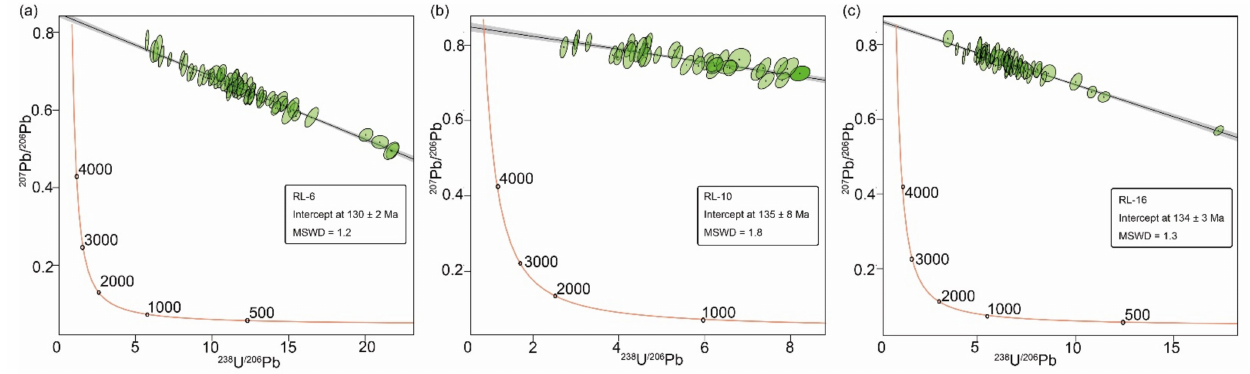
Figure 9. Apatite U-Pb lower intercept ages of the ( a ) RL-6, ( b ) RL-10, and ( c ) RL-16